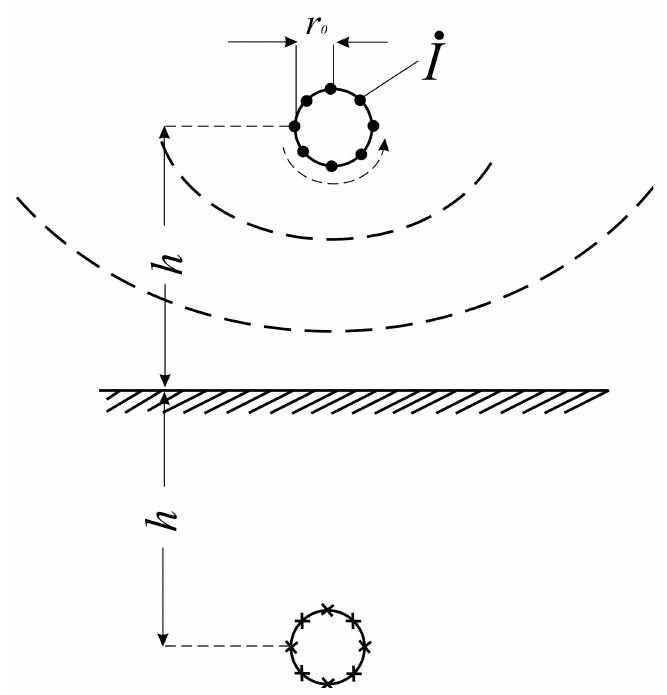
Figure 8. System “line wire—imaginary wire” without taking into account ground